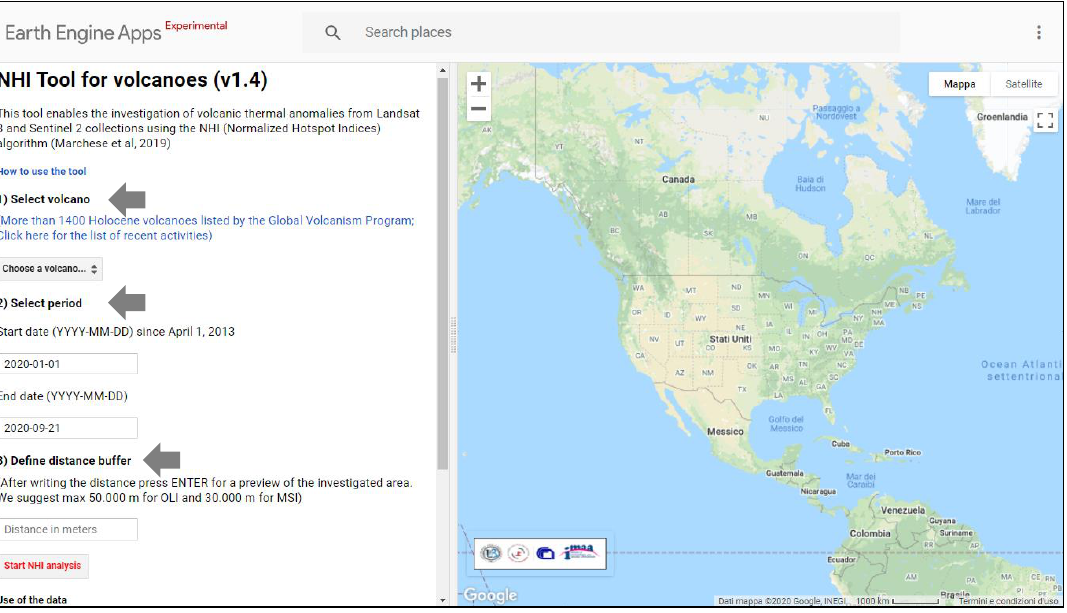
Figure 1. Graphical user interface (GUI) of the Normalized Hot spot Indices (NHI) tool. Gray arrows indicate the three fields required to start elaborations trough the “Start Analysis Button”.